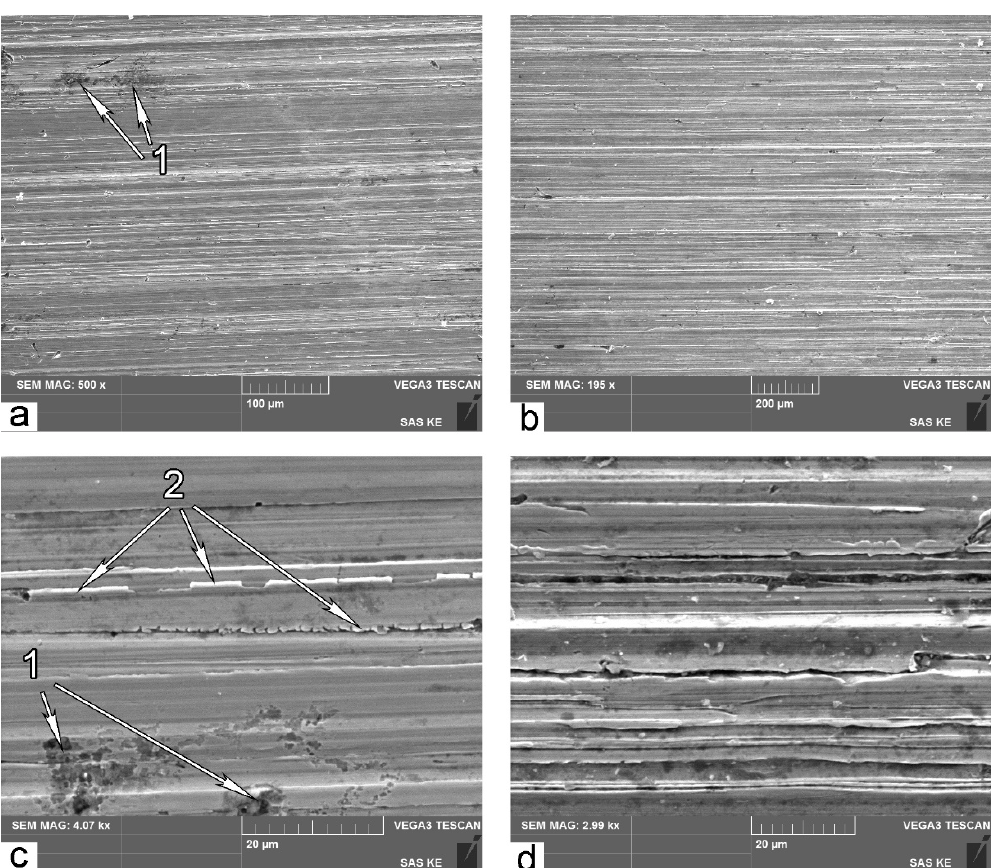
Figure 9. SEM micrographs of surface after wear in A mode: ( a , c ) A900 sample; ( b , d ) A1000 sample: 1—spots of fatigue damage; 2—cracking of ridges.